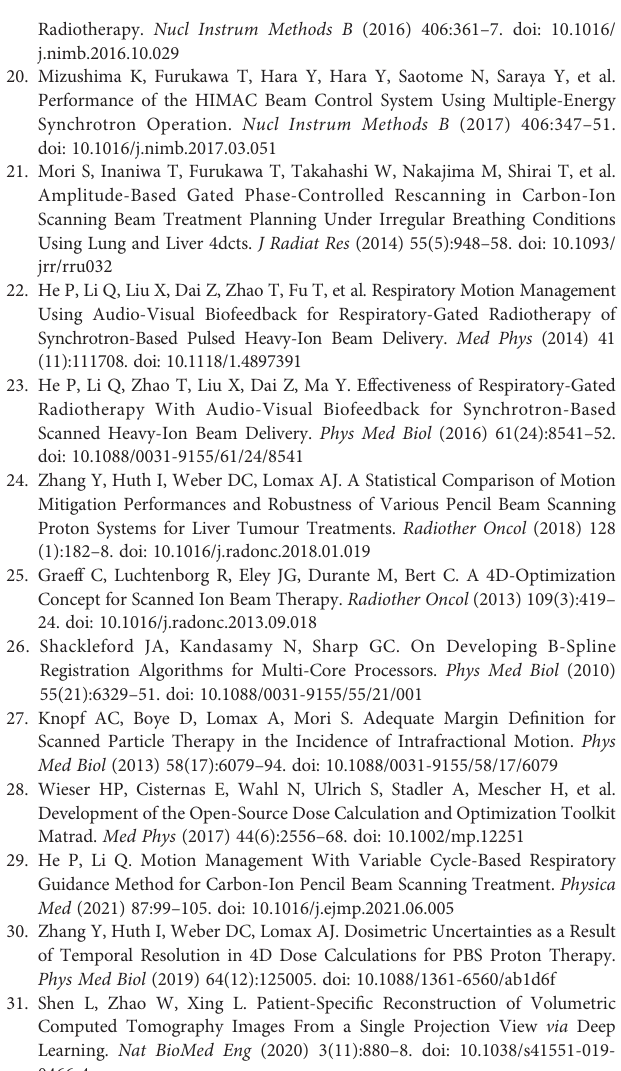
Supplementary Video 1 | The combination of gating with phase-controlled rescanning methods in the fi xed fl attop with single-energy synchrotron operation mode under the breathing guidance